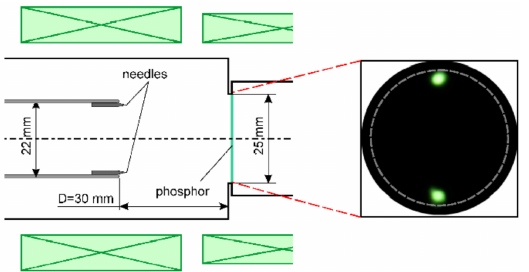
Figure 4. Diode configuration with 2-needle cathode; autograph of RAE